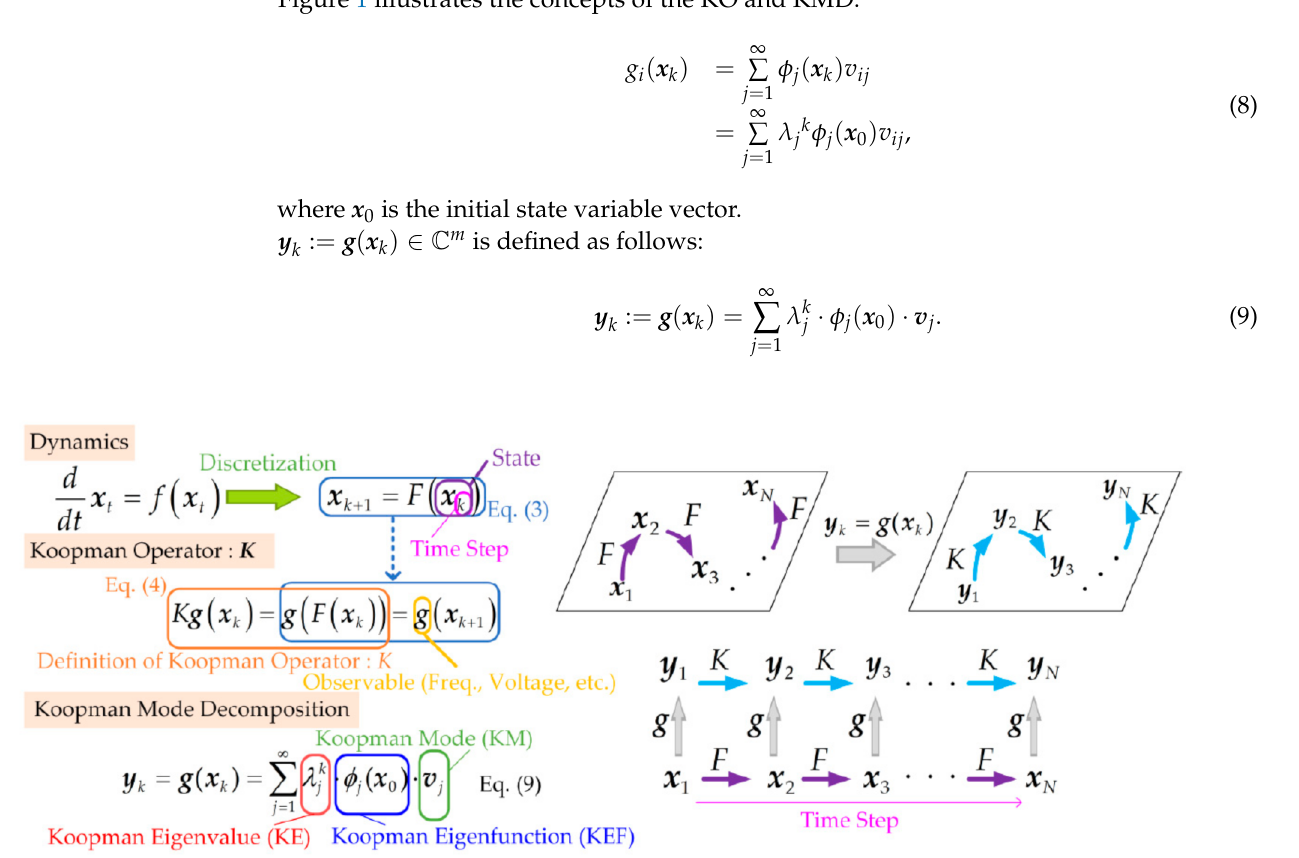
Figure 1. Conceptual illustration of the Koopman operator (KO) and Koopman Mode Decomposition